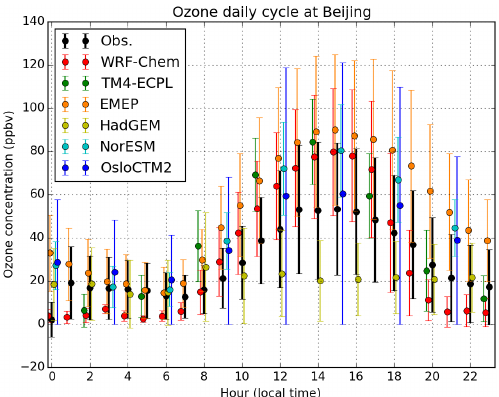
Figure 7. Ozone diurnal cycle as observed and as simulated by the ECLIPSE models in Beijing averaged over August and Septem- ber 2008. Whiskers represent 2 standard